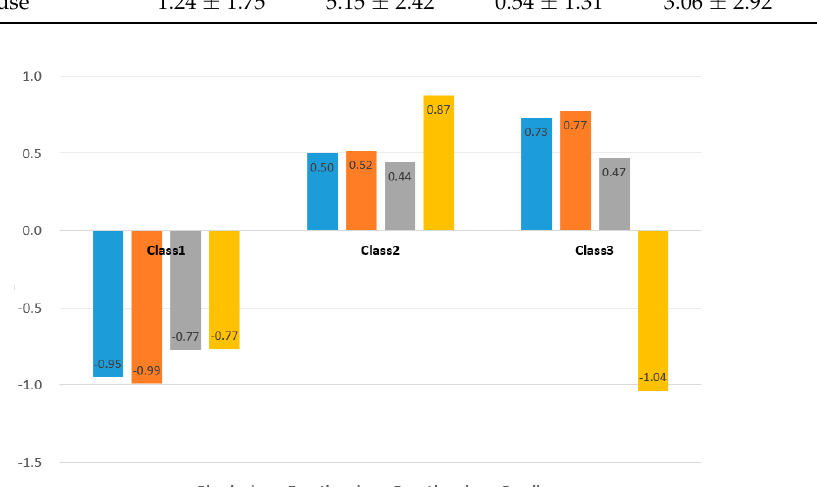
Figure 2. Illustration of z-score distribution of problem list in the three profiles defined in the latent profile analysis.